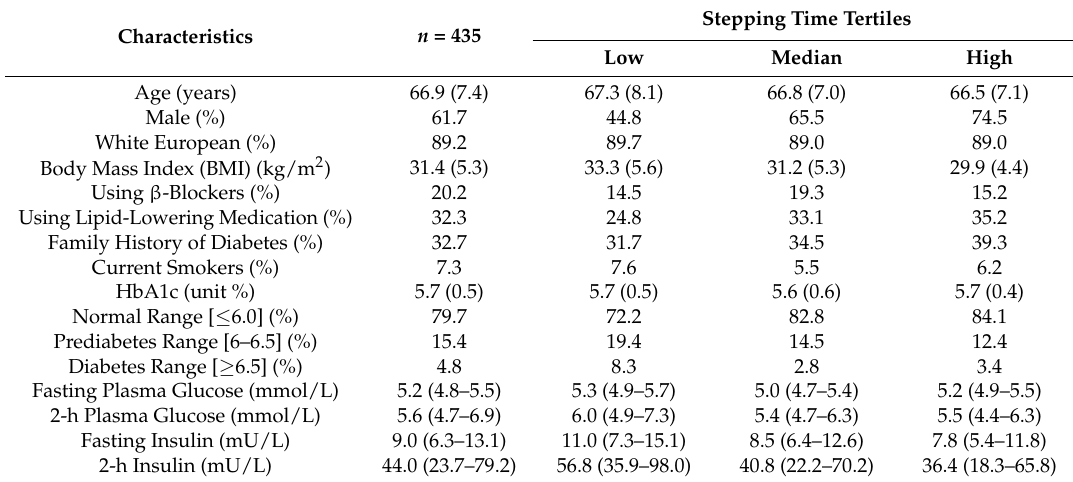
Table 1. Descriptive statistics.